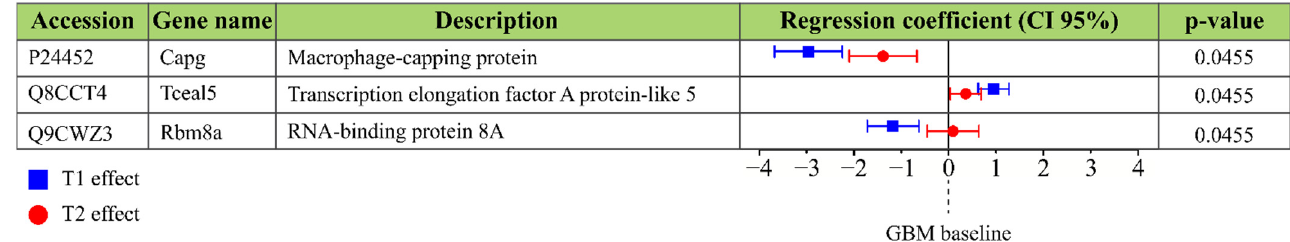
Figure 4. Protein groups that exhibited significant differences in the CSF dataset; p -values refer to the H0 hypothesis that all coefficients of the model are zero. Regression coefficients are reported in blue for a T1 (pre-symptomatic) effect and in red for a T2 (symptomatic) effect, with their confidence interval at 95%. Regression coefficients represent the fold change compared to the baseline.